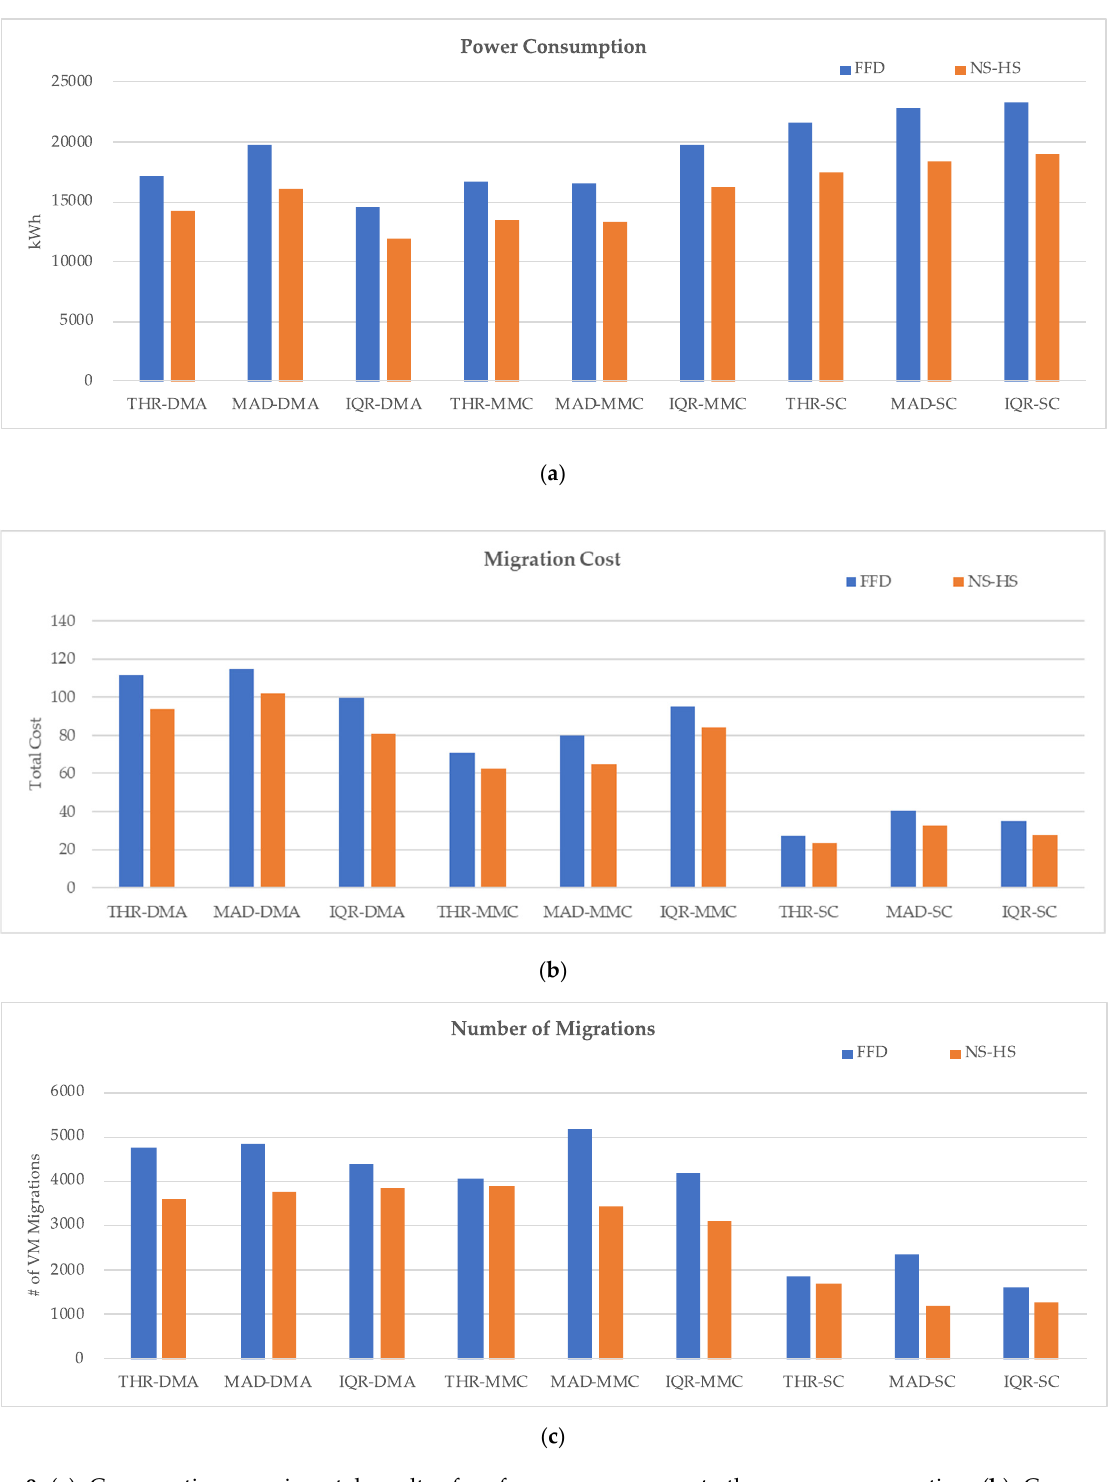
Figure 9. ( a ). Comparative experimental results of performance measures to the power consumption. ( b ). Comparative experimental results of performance measures to the migration cost. ( c ). Comparative experimental results of performance measures to the number of migrations.